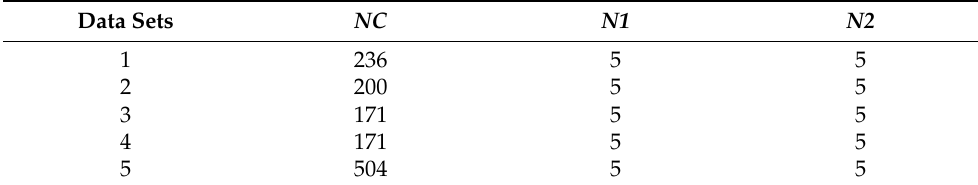
Table 1. Parameter values of the experimented data sets. Data